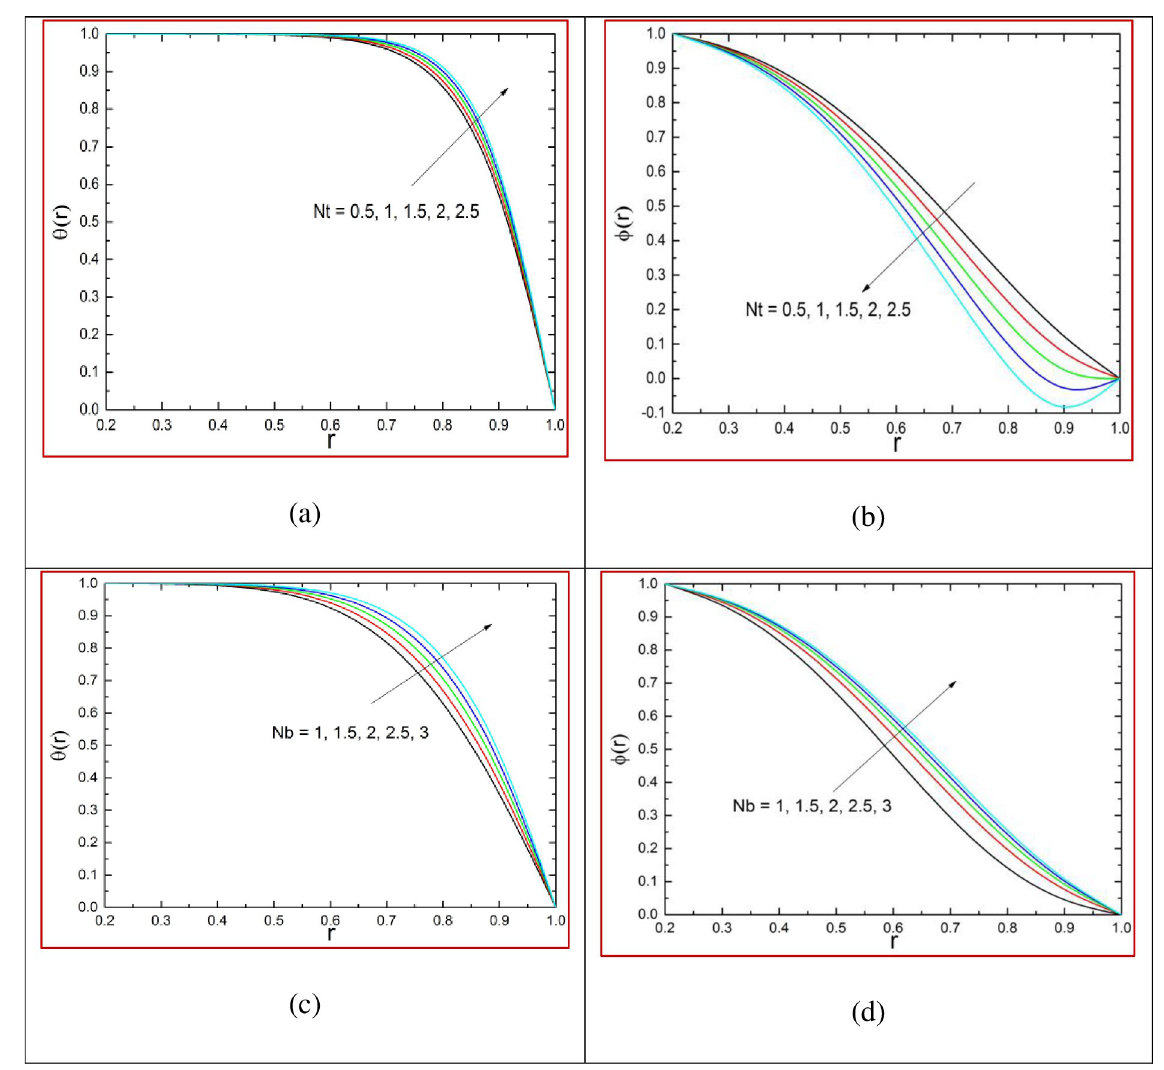
Fig 4. The impact of Nt and Nb on the thermal and concentration